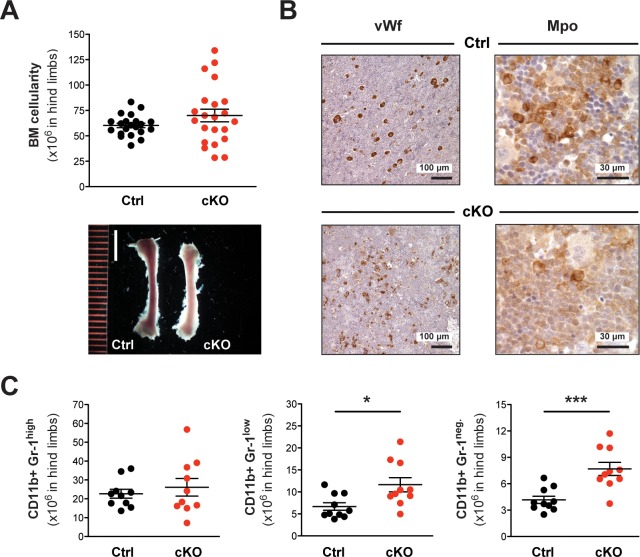
An abnormal cellular composition marks the BM of cKO mice.(A) The average BM cellularity (x106) in hind limb bones (2x femur, 2x tibia) of cKO mice (n = 22) was comparable to that of age-matched controls (n = 21) (7–25 weeks after induction). Depicted is the mean ± SEM (data derived from 12 independent tamoxifen inductions). The femoral bones in cKO mice appeared anemic (scale bar = 5 mm). (B) Immunohistochemical staining of femoral BM sections. In cKO tissue, vWf+ megakaryocytes appeared frayed and dysplastic compared to controls. Moreover, an increased but overall weak staining of Mpo+ myeloid cells was detected, indicating an excess of immature forms. (C) Quantification of FACS data with respect to total cellularity in both hind limb bones (x106) 16–26 weeks after induction (Ctrl n = 10, cKO n = 10). Both CD11b+ Gr-1low (p*=0.023) and CD11b+ Gr-1neg. (p***=0.001) myeloid cells were increased in cKO mice. Depicted is the mean ± SEM (data derived from three independent tamoxifen inductions).